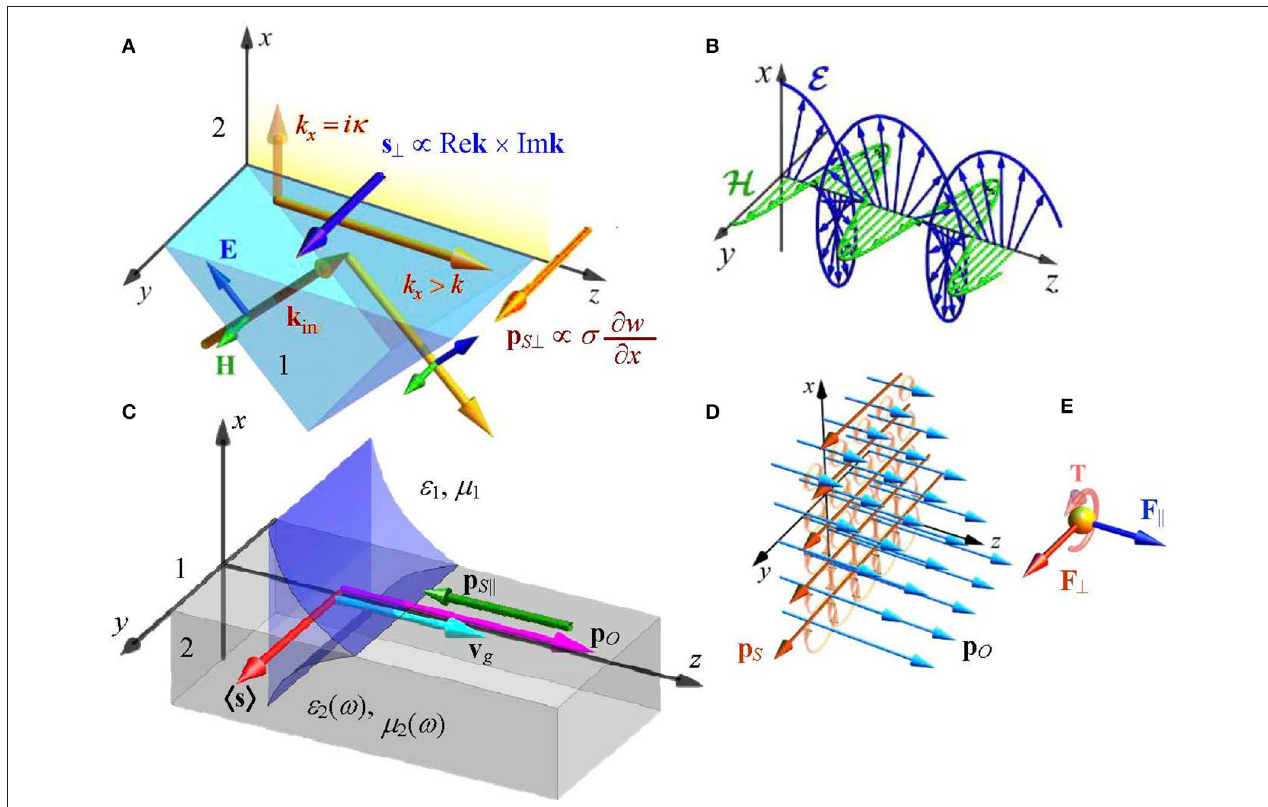
FIGURE 7 | Evanescent waves and their characteristics (adapted from [12, 39], © 2019 with permission from Elsevier). (A) Evanescent waves (EW) (55), (56) generated by the total internal reflection of a plane wave with the wavevector k in ; arrows show the wavevectors, transverse extraordinary SAM density (64) and the SM (65); (B) z -distribution of the instantaneous electric and magnetic fields E and H for the simplest linear x -polarization [TM mode with m (56)]. (C) Double-EW structure of the surface plasmon–polariton (SPP) propagating along the interface between media 1 (dielectric) and 2 (metal); the cyan, magenta, red, and green arrows show the group velocity, orbital momentum (OM), spin and the volume part of the SM, correspondingly. (D) Cross section of the EW with non-zero σ (54): blue arrows show the OM lines p O (with exponential decay in the vertical x -direction), closed loops, squeezing with growing x , symbolize the elliptic polarization whose inhomogeneity generates the transverse SM p S . (E) Main mechanical actions: longitudinal light-pressure force F transverse force F due to the extraordinary SM (65) and the longitudinal torque due to the helicity-dependent spin s z (63) [possible vertical torque produced by ⊥ electric or magnetic components of Equation (62) and the transverse torque due to the extraordinary spin (64) are not